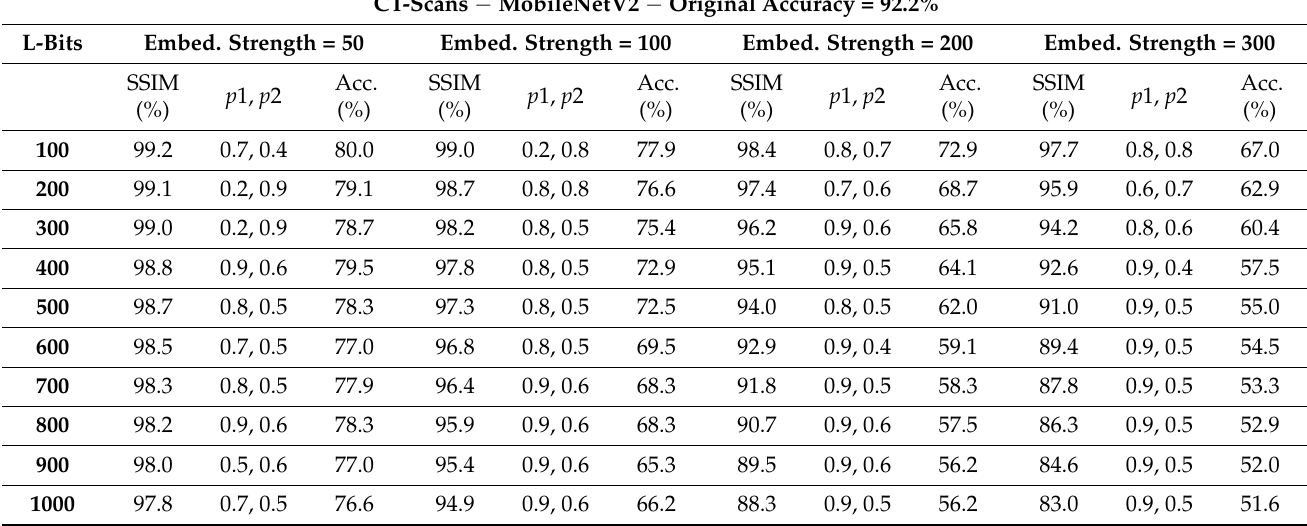
Table A4. KMsWA 2 attacks on MobileNetV2 in CT-Scans.